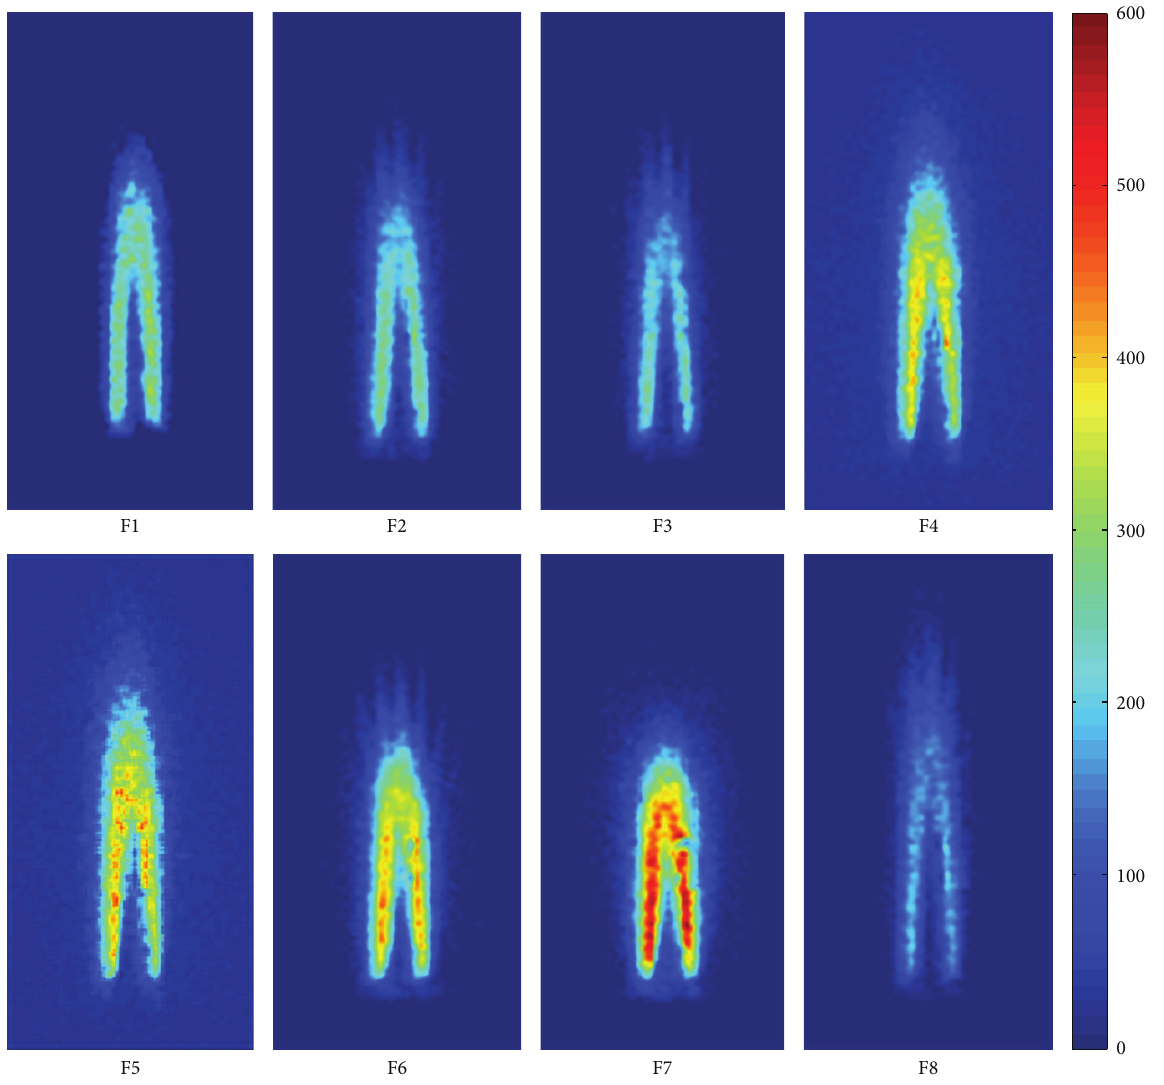
Figure 10: Reconstructions of the OH ∗ chemiluminescence in different flame